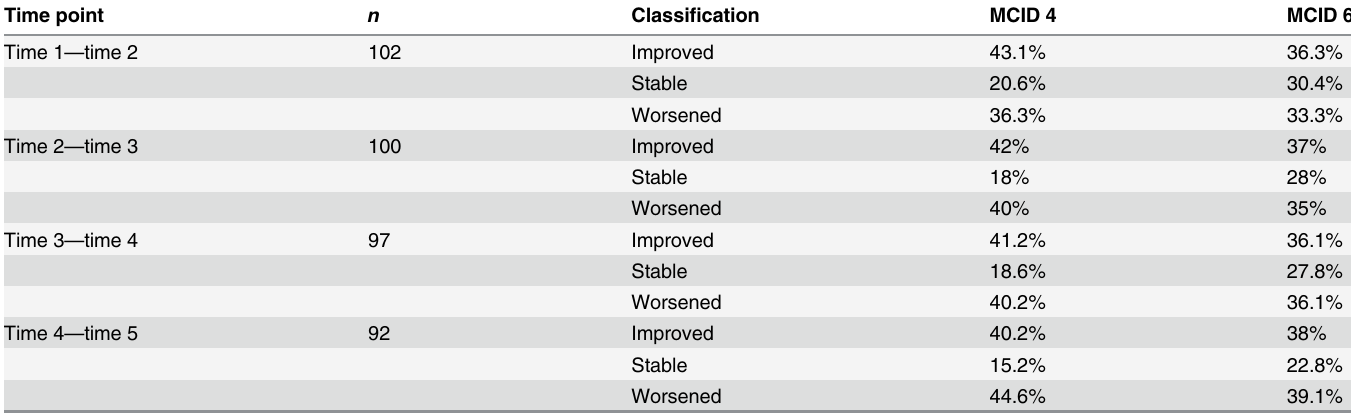
Table 6. Percentage of patients classified as improved, stable, or worsened in MSWS-12 scores across successive 6-month time periods based on MCID values of 4 and 6. Time